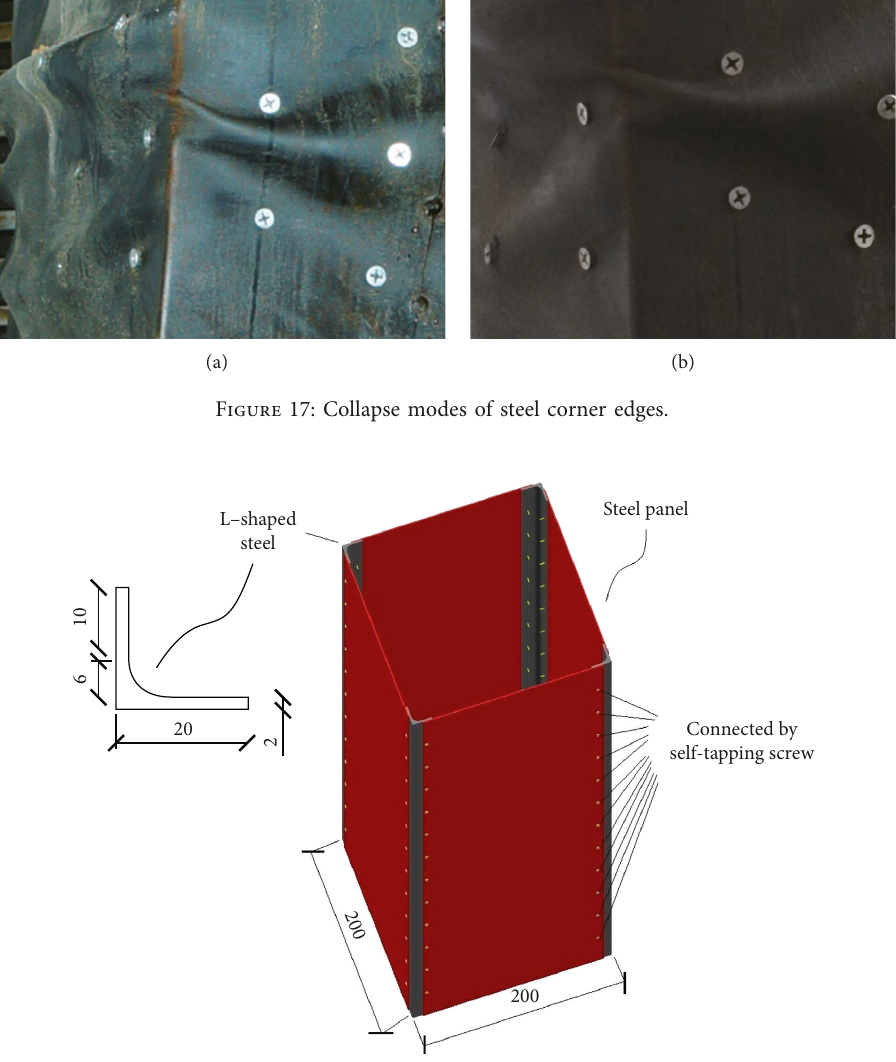
Figure 18: Steel tube of optimization model L650.